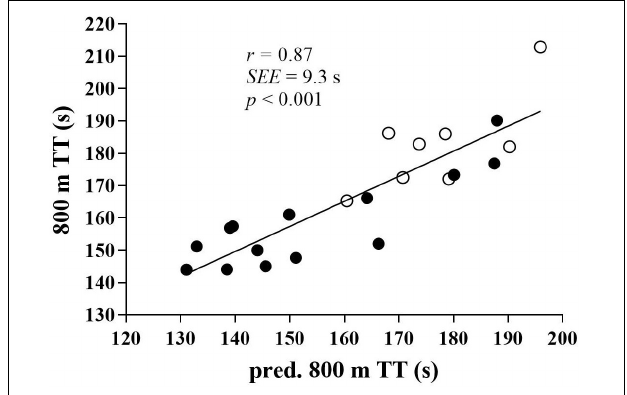
FIGURE 1 | The relationship between predicted and measured 800TT. Values are predicted 800TT (time trial) in seconds (s) on the x -axis and measured 800TT (s) on the y -axis. Males are denoted in black circles, and females are indicated in white circles. The correlation is statistically significant ( p < 0.001). r , correlation coefficient. SEE, standard error of the